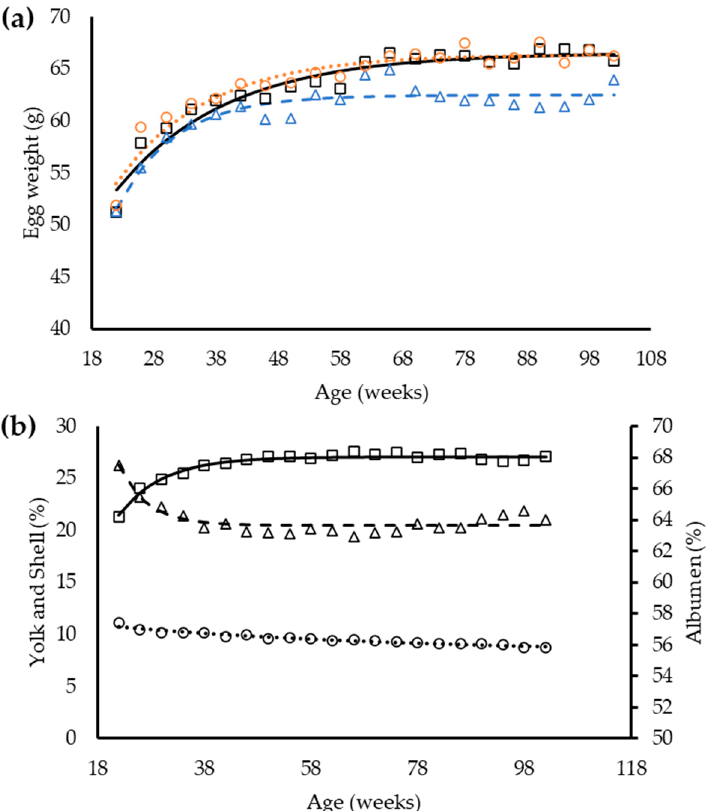
Figure 3. Observed and predicted egg weight ( a ) of laying hens from 19 to 102 weeks old in response to age in three dietary balanced protein levels (standard ( □ , —); low ( ∆ , - -), and high ( ○ , ∙∙∙ )), and egg components ( b ) yolk ( □ , —), albumen ( ∆ , - -) and shell ( ○ , ∙∙∙ ).